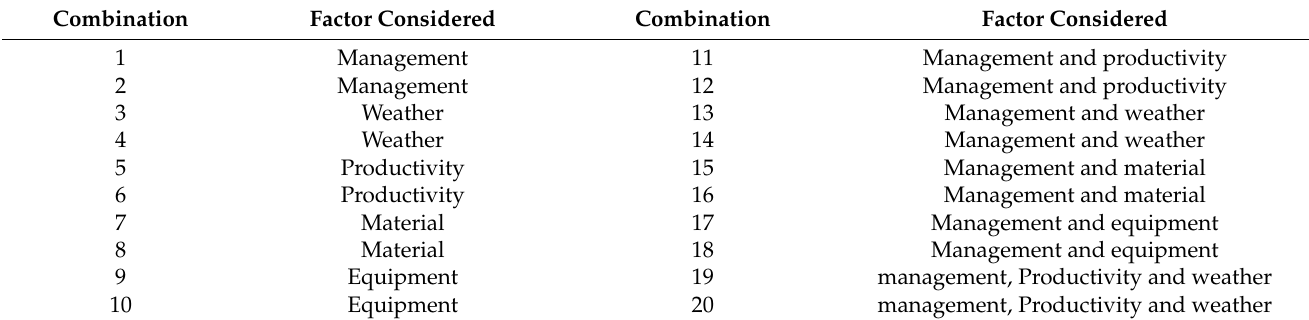
Table 5. Potential Factor Combinations and Their Logic Gate.